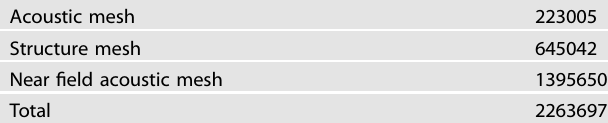
Table 2. Number of